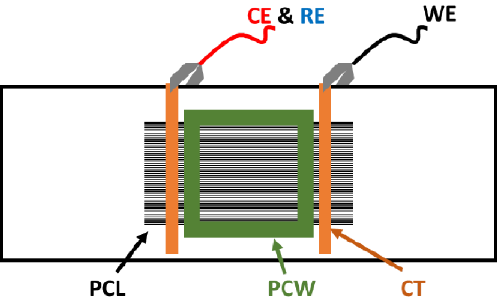
Figure 3. Experimental setup for electrical stimulation of electroactive PCL-based tissue scaffolds (Not to scale). (CE) counter electrode. (CT) copper tape. (PCL) electroactive PCL-based tissue scaffolds. (PCW) polycarbonate well. (RE) reference electrode. (WE) working